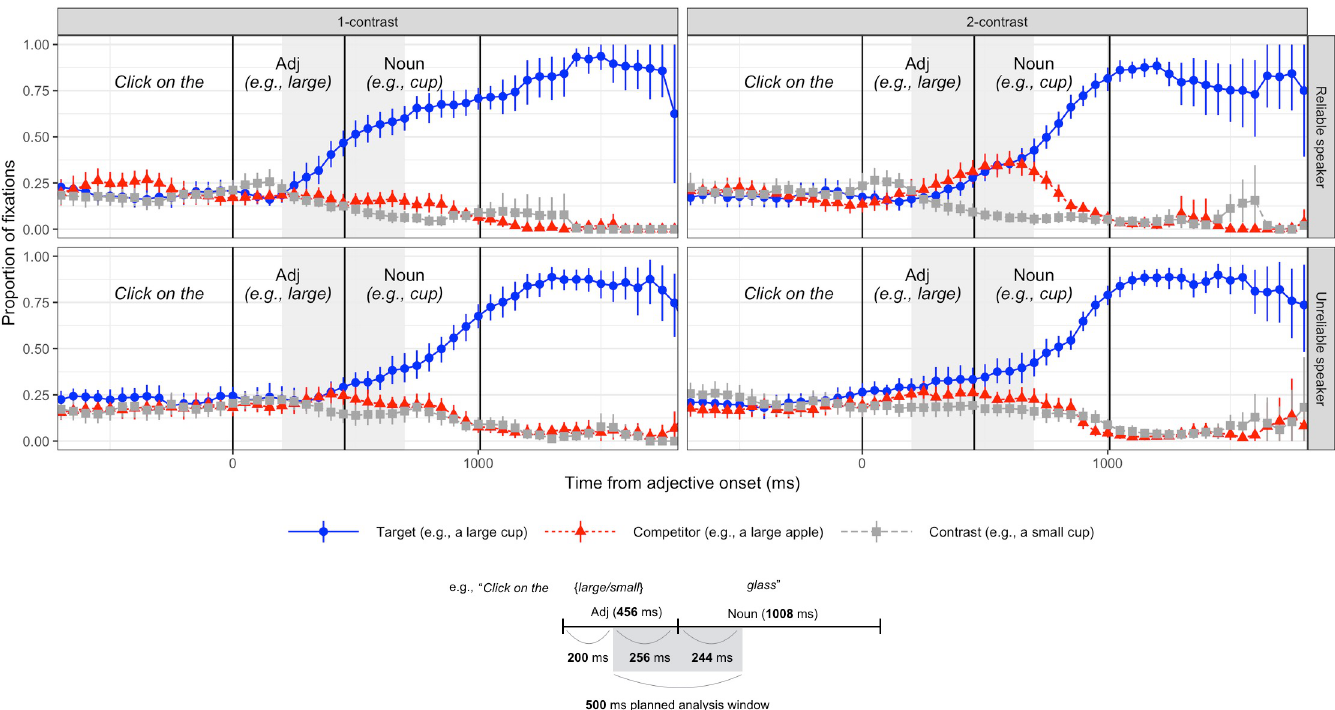
Fig 2. A. Time-course of fixations during instructions relative to the onset of the adjective (e.g., Click on the large cup) in the reliable (top) and unreliable (bottom) speaker conditions in Experiment 1. Vertical lines indicate the average adjective onset, adjective offset, and noun offset. Shaded area indicates the 500 ms planned analysis window. Points represent averages of by-participant means in each time bin. Error bars represent 95% bootstrapped confidence intervals over those by- participant means. B. Average duration of the scalar adjectives and the final nouns and their alignment with the 500ms planned analysis window.